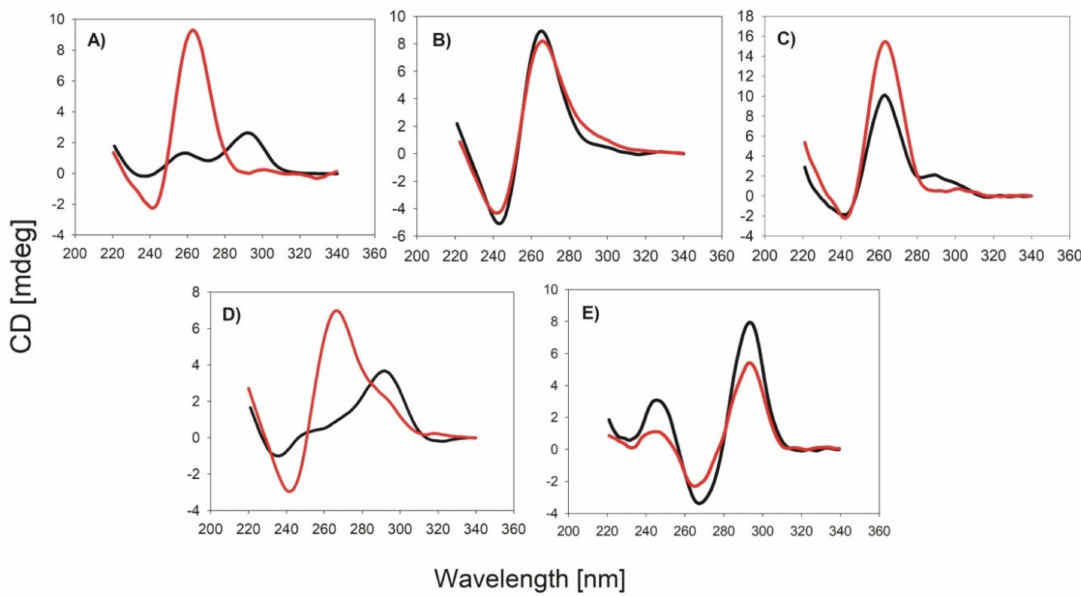
Figure 1. CD spectra of G4-hem conjugates (red) and G4 oligonucleotides (black) for PS2.M ( A ), CatG4 ( B ), AGRO100 ( C ), HT22 ( D ) and TBA ( E ). Conditions: 2 µ M DNA, 100 mM KCl, 10 mM Tris-HCl (pH =